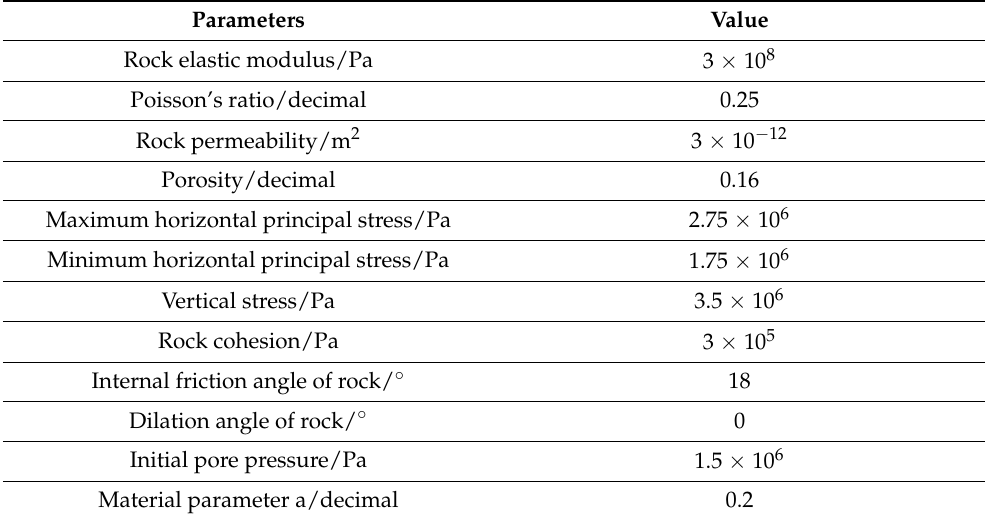
Figure 2. Schematic of the finite element model of borehole stability and mesh division. Table 2. Input parameters in finite element simulation of rock borehole instability (Base case).